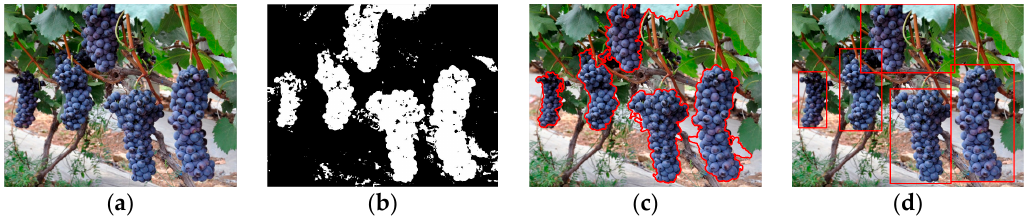
Figure 10. Detection process of the Cabernet Sauvignon grape clusters ( a ) Original image; ( b ) Initial segmentation image by the developed classifier; ( c ) The contour of the detected grape clusters; and ( d ) Detection result.